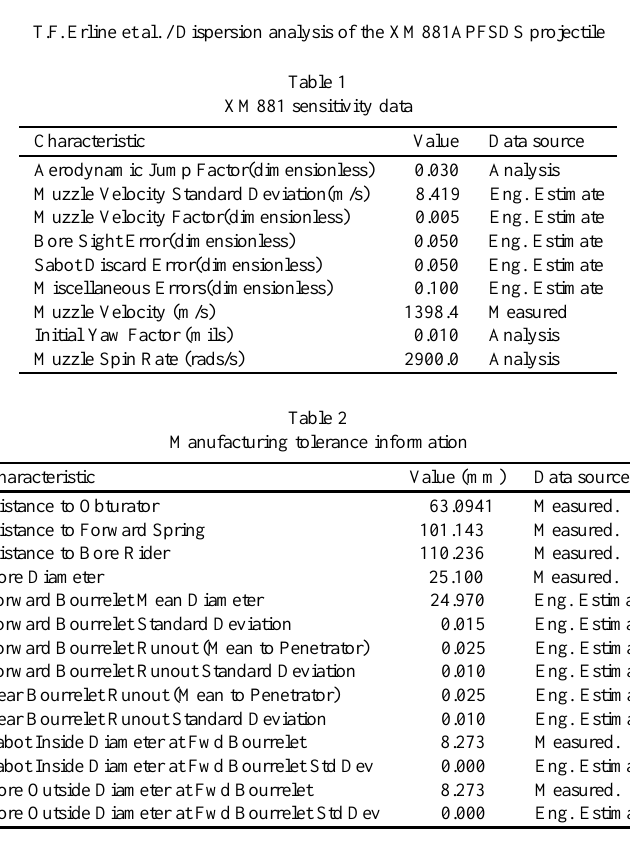
Table 3 Simulated TID results of 10 simulations of 10 round tests Simulation